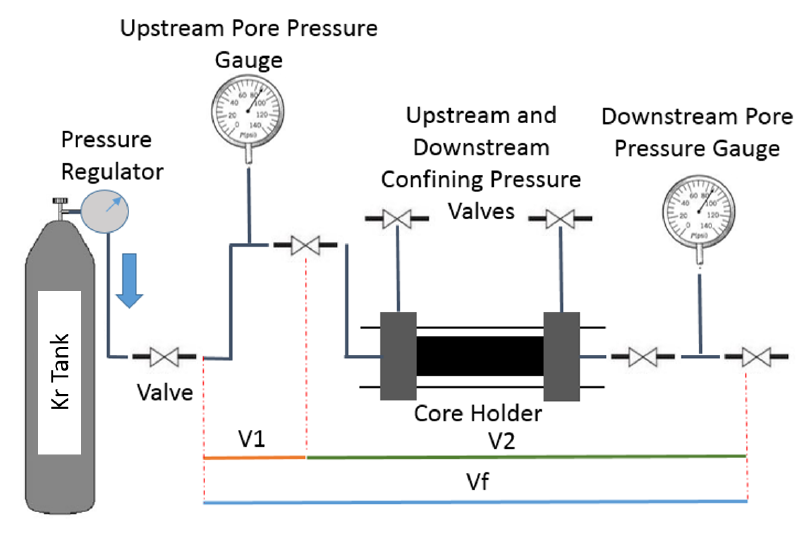
Figure 3. Pulse decay experimental setup for mass balance determination of gas storativity in rock. Setup is placed on a CT table for image acquisition after reaching pressure equilibrium for each pressure